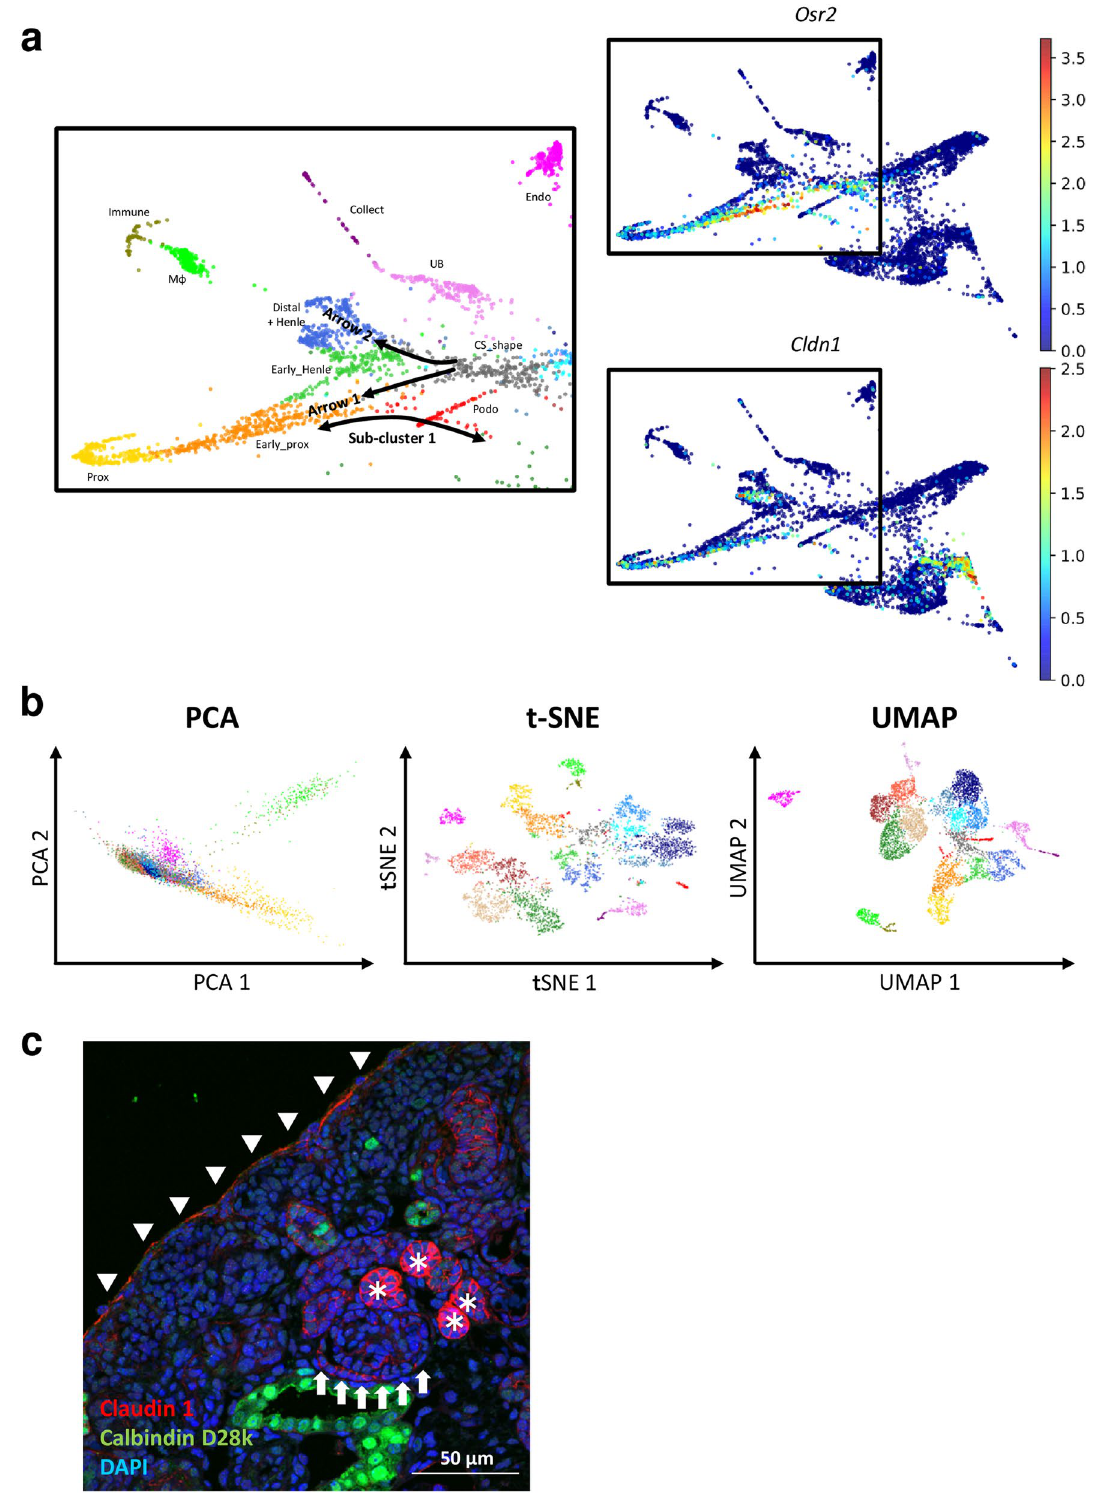
Figure 2. PAGA-initialized ForceAtlas2 enabled the identification of a sub-cluster that represented the Bowman’s capsule. ( a ) The left portion of Fig. 1b is shown with the addition of several annotating arrows. Expression levels of odd-skipped related 2 ( Osr2) and claudin-1 ( Cldn1) are also presented. Three black squares indicate the same portion in the PAGA-initialized ForceAtlas2 map. ( b ) Cells were visualized with principal component analysis (PCA), t-distributed stochastic neighbor embedding (t-SNE), and uniform manifold approximation and projection (UMAP). Dot colors indicate clusters shown in Fig 1. ( c ) Mouse embryonic kidney section at day 18.5, immunohistochemically stained with claudin 1 in red, calbindin D28k in green, and 4’,6-diamidino-2-phenylindole (DAPI) in blue (scale bar: 50 µm). Data were analyzed using Scanpy version 1.4.4.post1 (https ://scanp y.readt hedoc s.io/en/stabl e/). Arrows indicate the parietal epithelial cells of the Bowman’s capsule. Arrowheads and asterisks indicate the surface of the kidney and the distal tubules,